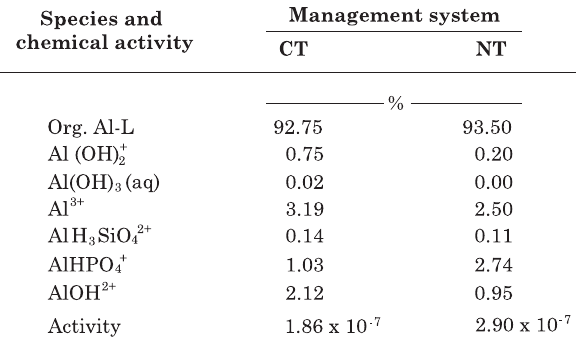
Table 3. Aluminum speciation and activity in the solution of a subtropical Oxisol under conventional tillage (CT) and no-tillage (NT), at pH = 4.9 and Al = 0.22 mg L -1 under CT; and pH = 4.7 and Al = 0.53 mg L -1